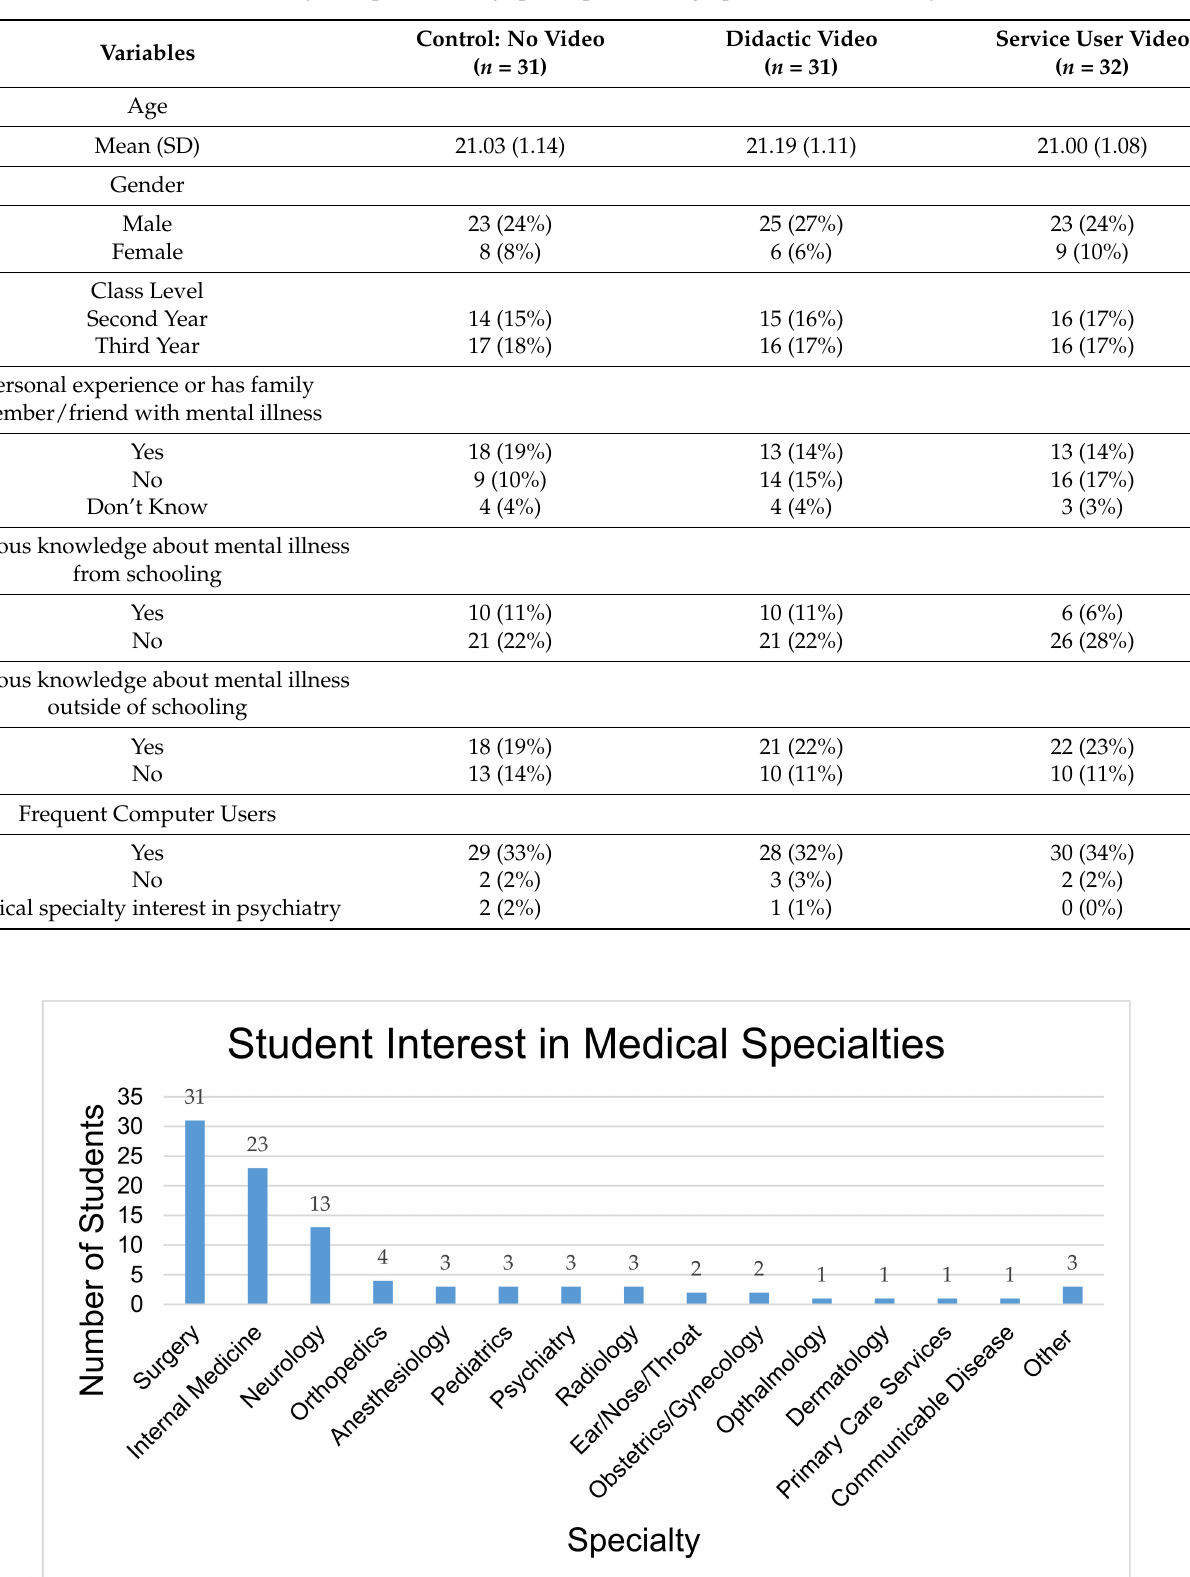
Table 2. Study 1 (depression only) participant demographic characteristics by arm.